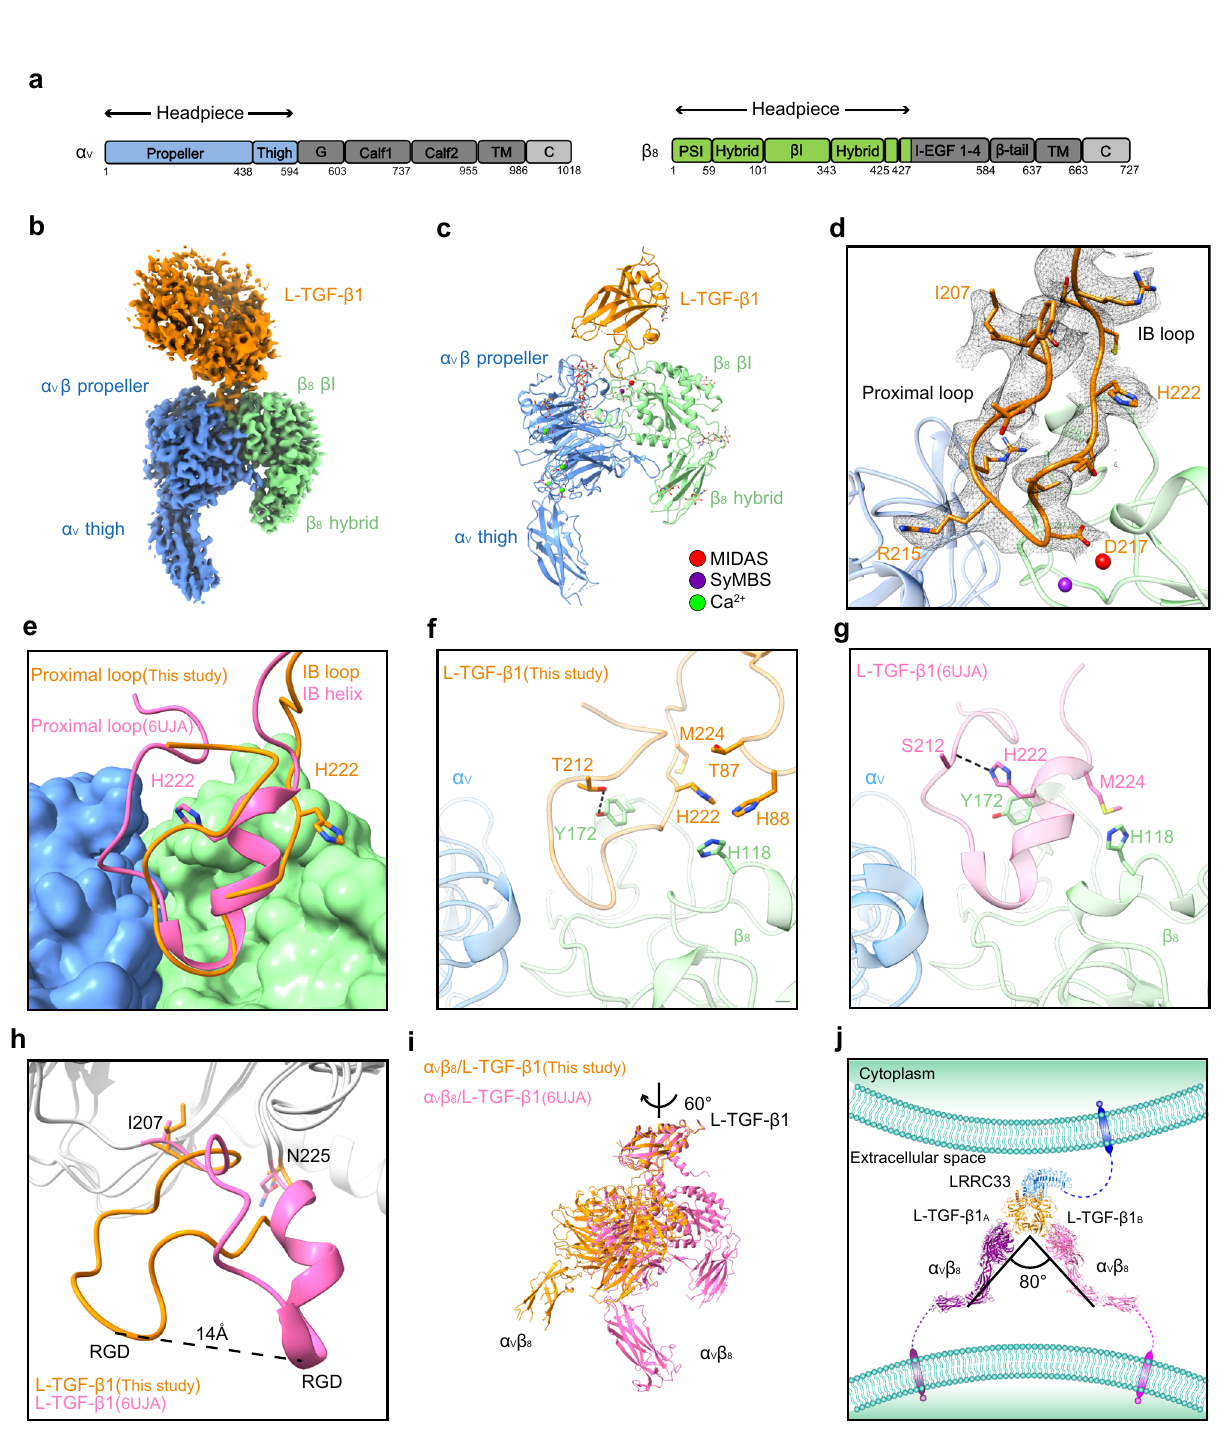
Fig.2|Non-covalentinteractionisessentialfortheL-TGF- β 1/LRRC33assembly and determines L-TGF- β isoform speci fi city. a Surface L-TGF- β 1 (anti-HA) expressions on transfected Expi293F cells were measured by fl ow cytometry. Numberineachhistogramindicatesthepercentageof L-TGF- β +(anti-HA+)subset. b MFI(MeanFluorescenceIntensity)ofL-TGF- β (anti-HA)ondifferentlytransfected Expi293F cells. All experiments were done in triplicate ( n =3 biologically indepen- dentexperiments,mean±s.d.). c CulturesupernatantsandtotallysatesofExpi293F cells transfected with indicated plasmids were subjected to non-reducing and reducing immunoblot analyses with anti-HA antibody (for L-TGF- β ). The experi- ment was repeated three times independently with similar results. d Surface pre- sentations of different L-TGF- β isoforms by LRRC33 were measured by fl ow